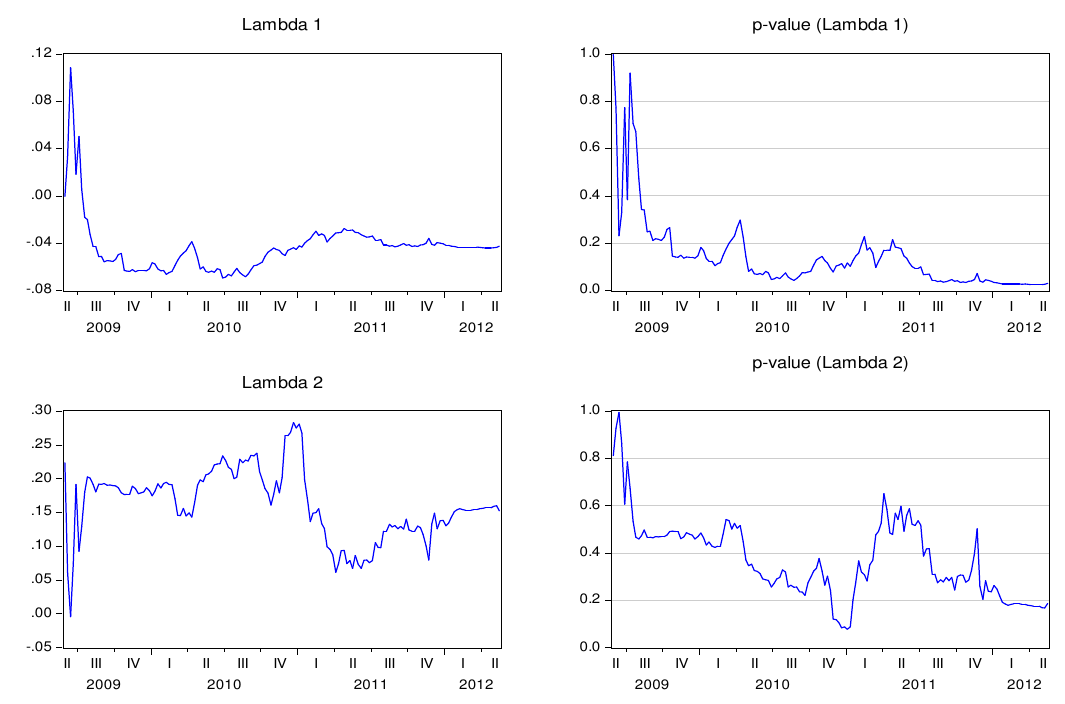
Figure 2. Recursive estimation of the speed adjustment parameters —